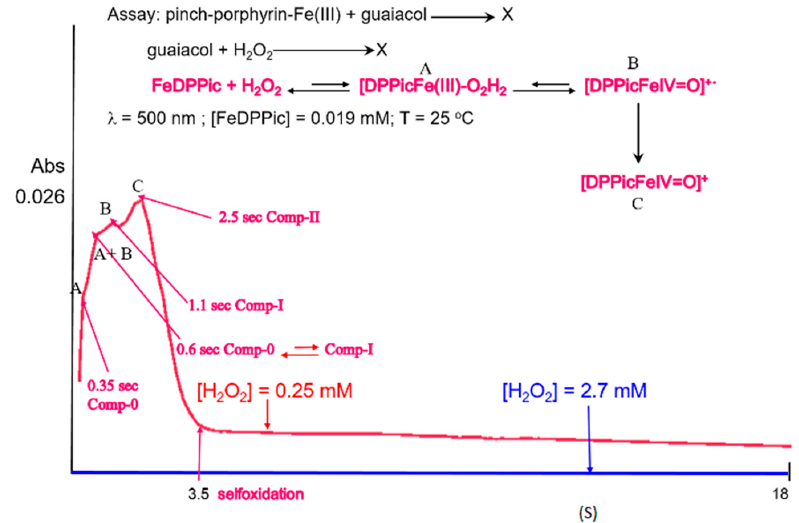
Figure 3. Kinetic pathway of the reaction [FeDPPic] (MeOH) + H 2 O 2(aq) at the first four seconds of reaction and at 500 nm ( ― ). The blue line ( ― ) corresponds to the condition with the H 2 O 2(aq) concentration one magnitude order higher.